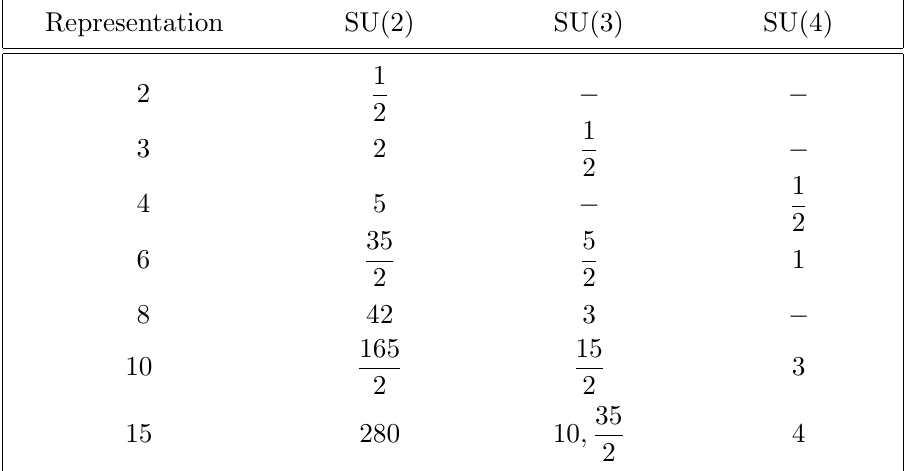
Table 3 . Dynkin index T i for several irreducible representations of SU(2), SU(3), and SU(4). Di(cid:11)erent normalization conventions are used in the literature. For instance, there is a factor of